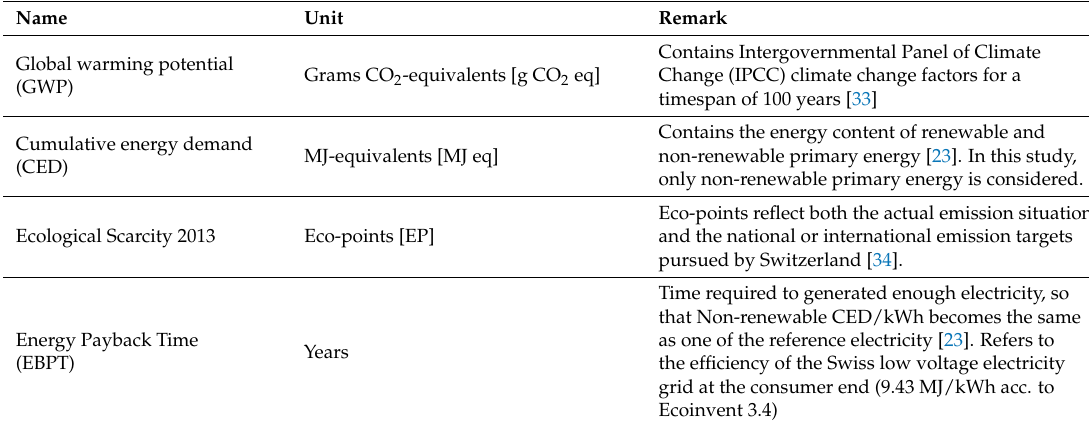
Table 5. Indicators selected for the life cycle impact assessment (LCIA) in this